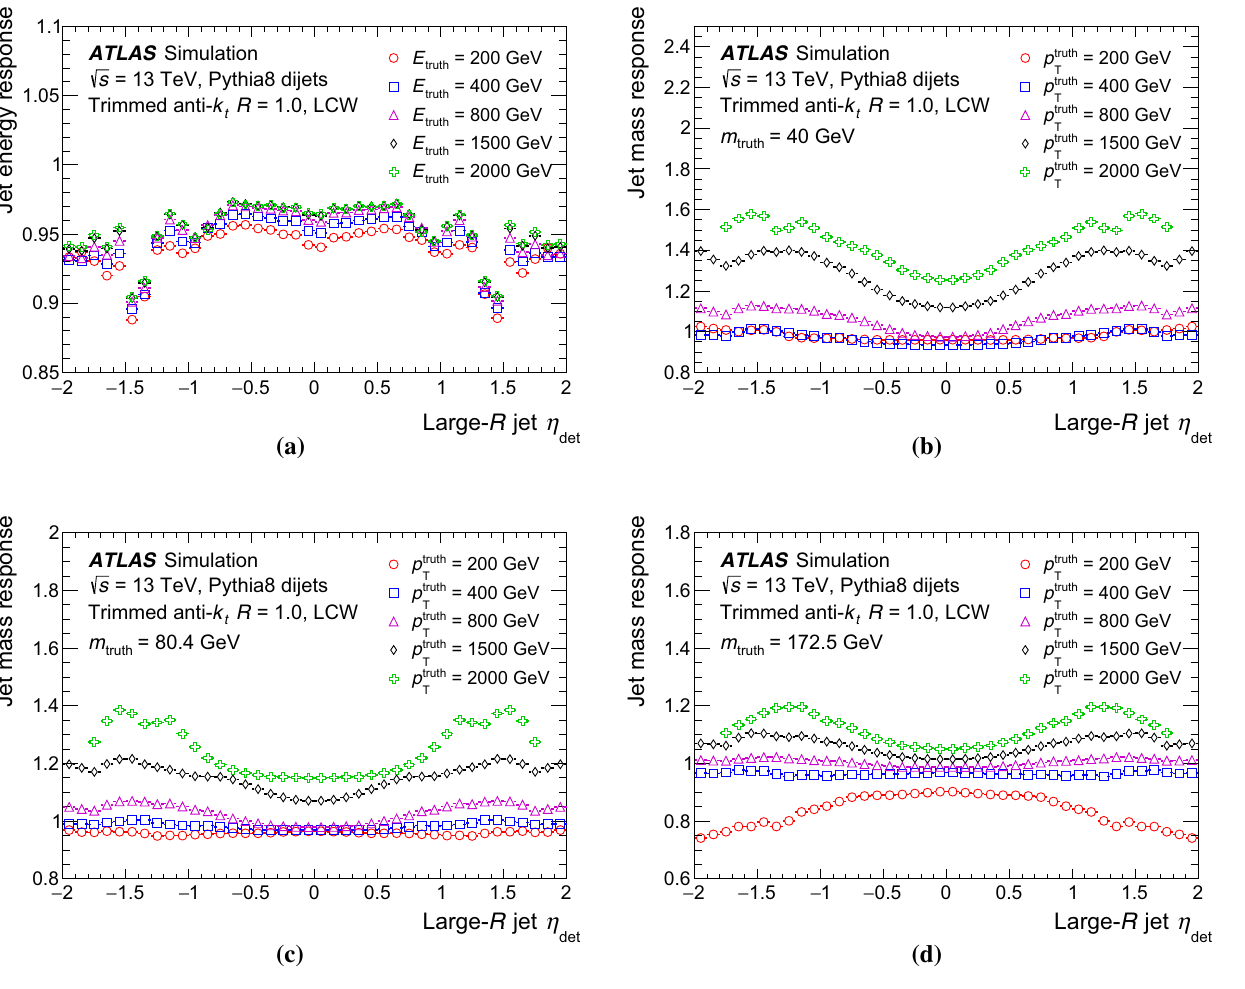
jet mass: b 40 GeV, representing a typical value for quark or gluon jets, c the W boson mass, and d the top quark mass. The response is deter- mined in simulation of dijet events as the ratio of the reconstructed jet mass to the mass of the corresponding particle-level jet. These results are used to define the jet-level mass correction applied in the simulation calibration